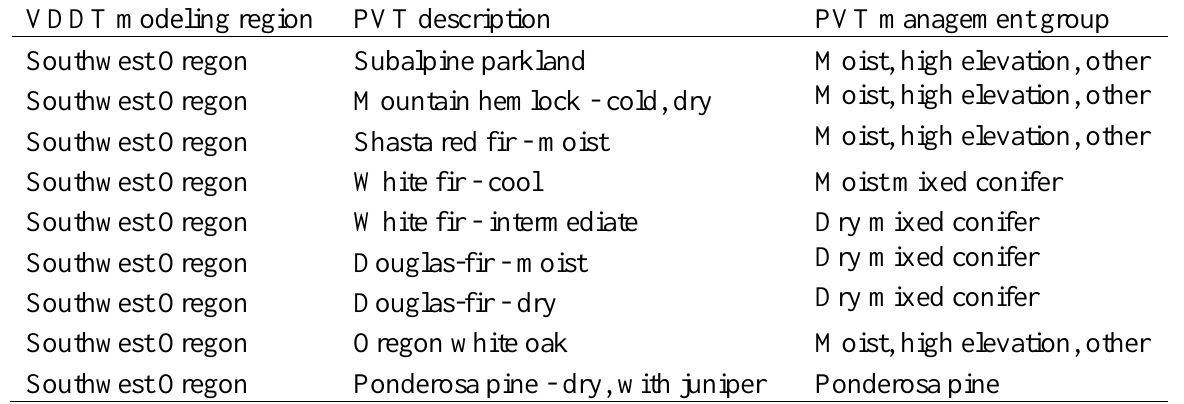
Table A1.1. Contd.